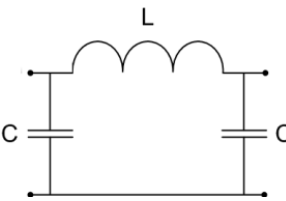
Figure 5. Lumped element model of an electrically short section of the lossless transmission line.